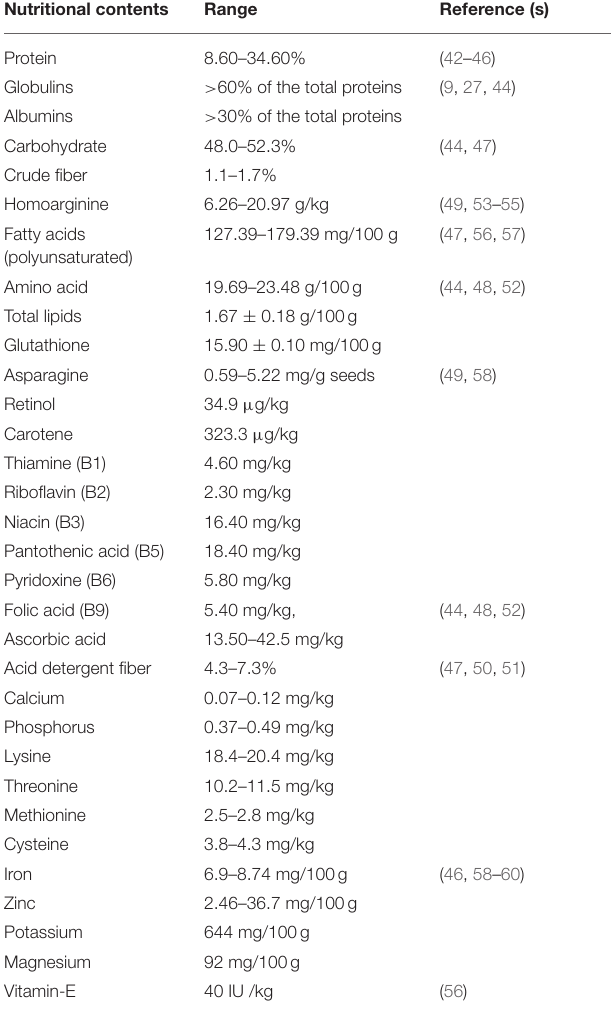
TABLE 2 | Nutritional profile of grasspea ( L. sativus